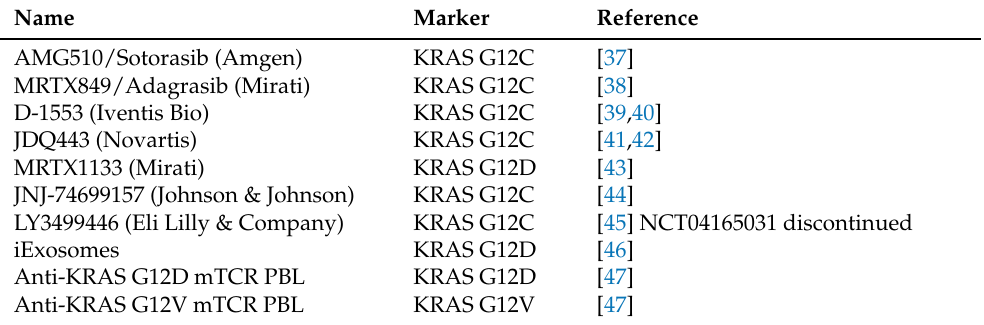
Table 1. Recent advances in targeting specific KRAS